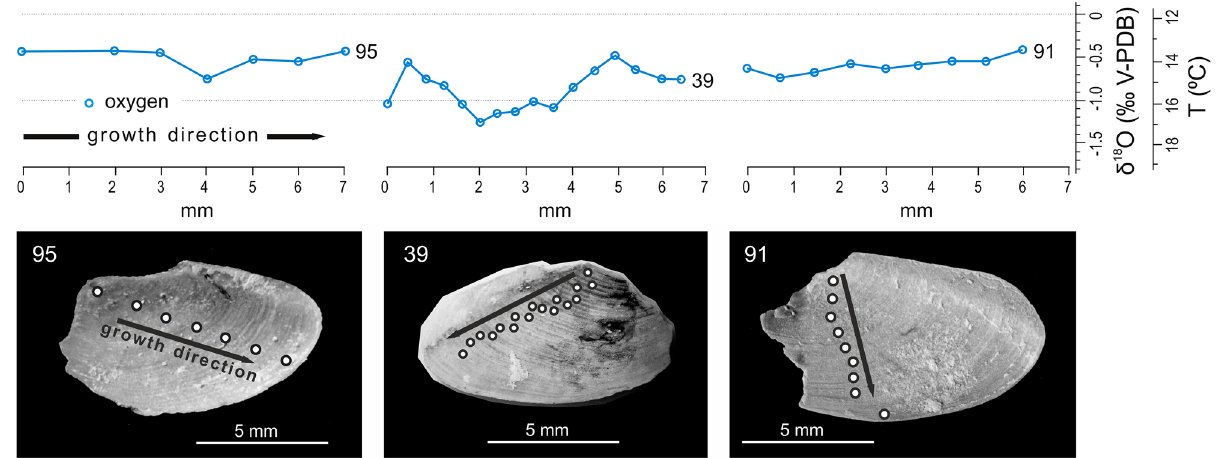
Figure 5. Examples of ontogenetic δ 18 O variation in aptychi of Hoploscaphites constrictus (from left to right: ZPAL Am. 24/95 from interval A, 39 from interval B, and 91 from interval C), photographed from their concave, anatomically dorsal, side which reveals growth increments (compare Machalski, 2021 22 ); white circles denote sampling